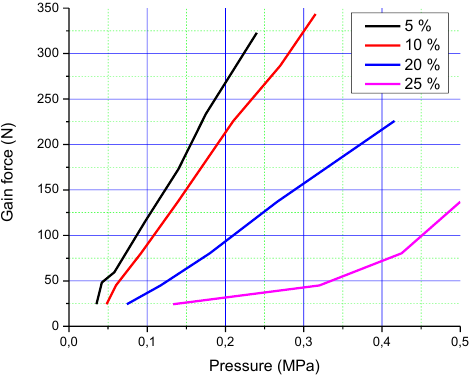
Fig. 10. The isometric characteristics of the pneumatic artificial muscle PAM-20-330